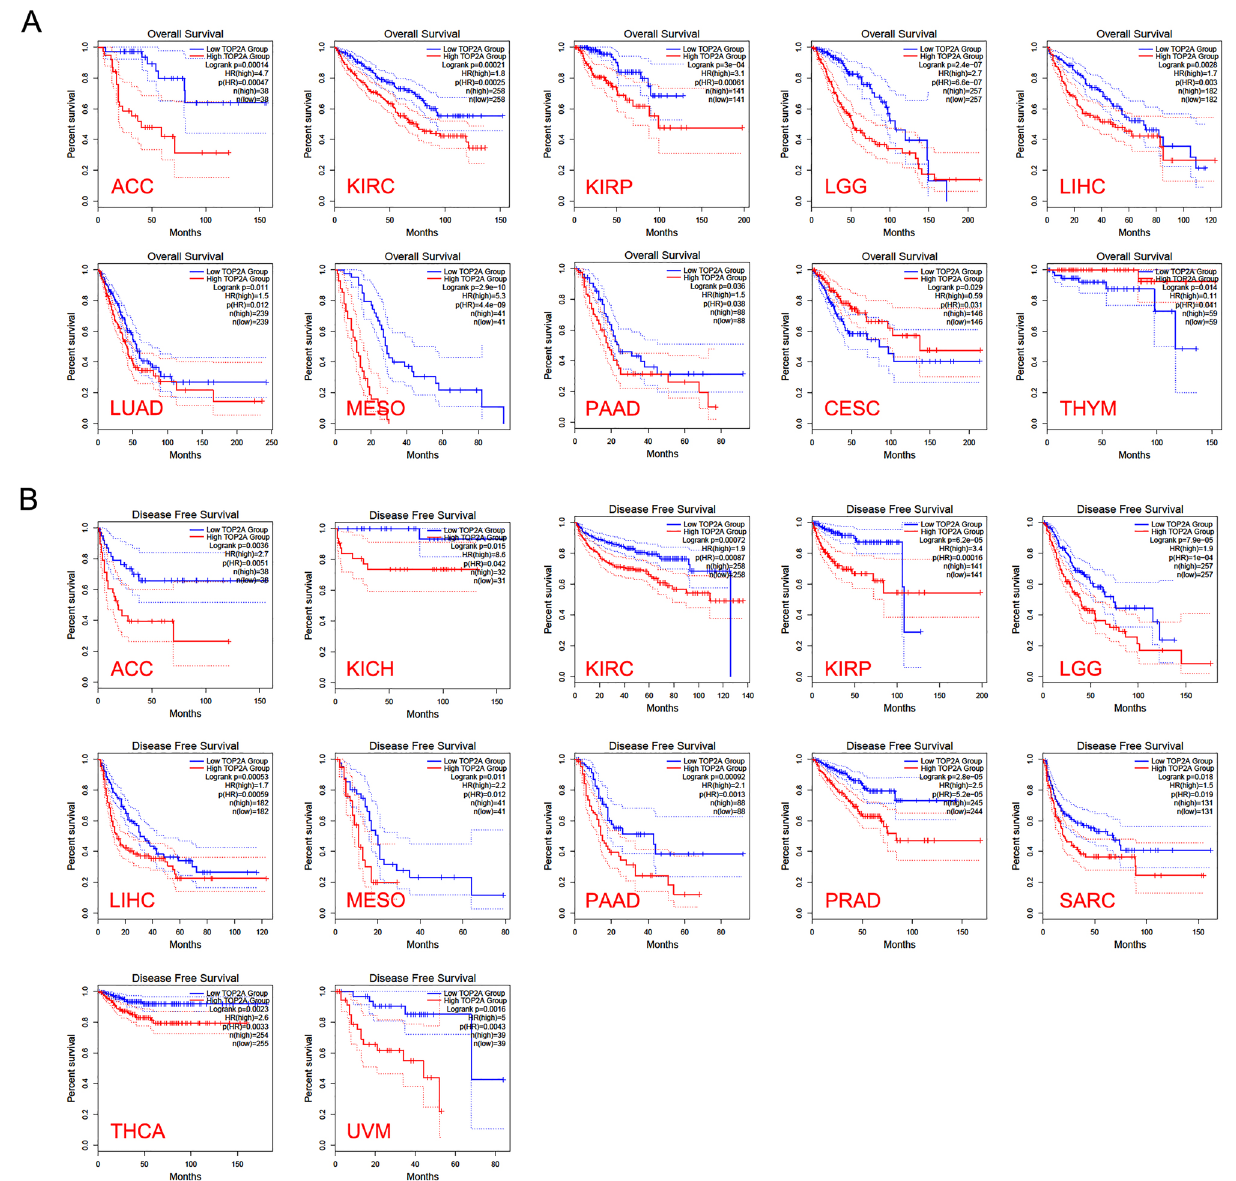
Figure 2. The overall survival analysis ( A ) and disease-free survival analysis ( B ) based on TOP2A expression in various